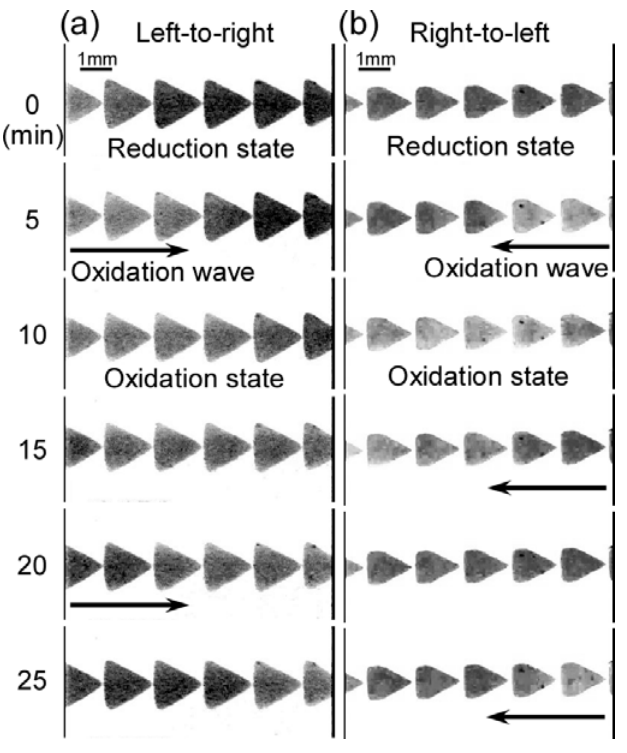
Figure 7. Propagating behavior of the chemical wave on the (a) triangular gel array and (b) pentagonal gel array (Reference